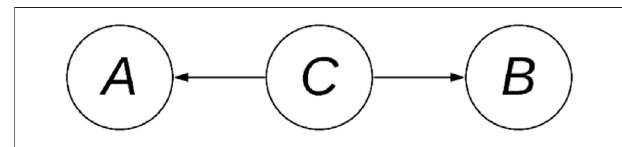
FIGURE 1 | A DAG with three variables (A – C) and two